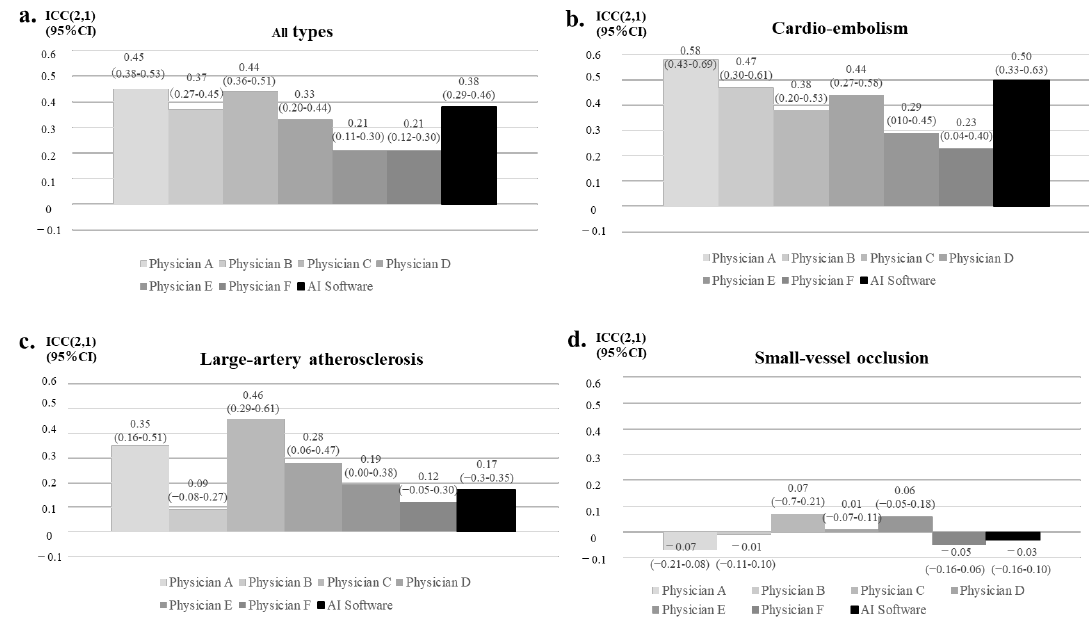
Figure 3. The reading accuracies of the AI software and neurologists in patients who had undergone CT images within 48 h of presentation. The reading accuracies of the AI software and neurologists against the BS criteria for all types of ischemic stroke patients ( a ), for cardio-embolism ( b ), for large- artery atherosclerosis ( c ), and for small-vessel occlusion ( d ). The type of physician is shown on the X axis; board-certified vascular neurologists (physicians A and B), neurology fellows (physicians C and D), and neurology residents (physicians E and F). The inter-assessor reliability of the total ASPECTS is shown in Y axis.